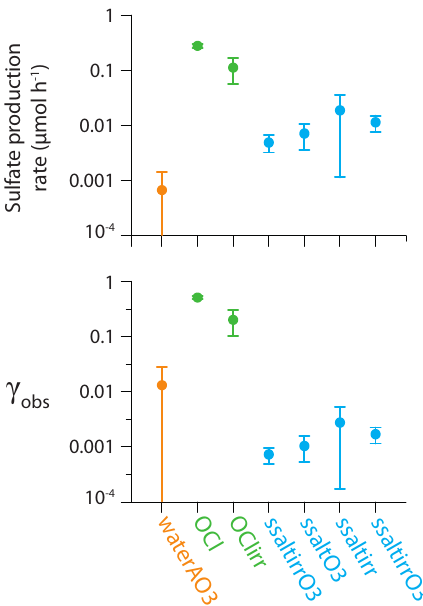
Fig. 4. Rates of sulfate production and reactive uptake coefficients for SO 2 (g) oxidation in different aerosol types subject to various experimental parameters (abbreviations are defined in Table 1).